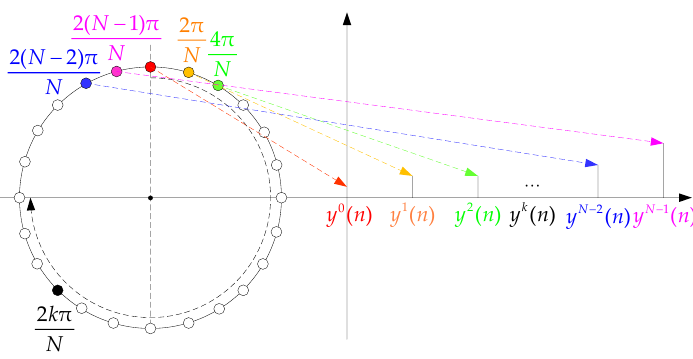
Figure 2. Demonstration of all-phases (traversing all-phases of angular frequency, the value of which is ω= 2 π / k N , in the unit circle).